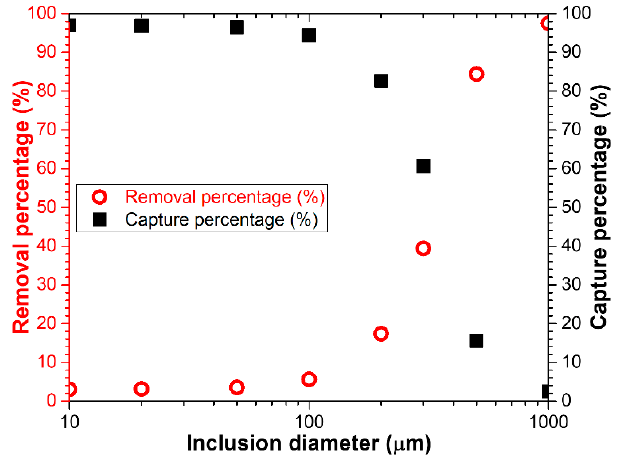
Figure 17. Removal percentage and capture percentage by inclusion size.